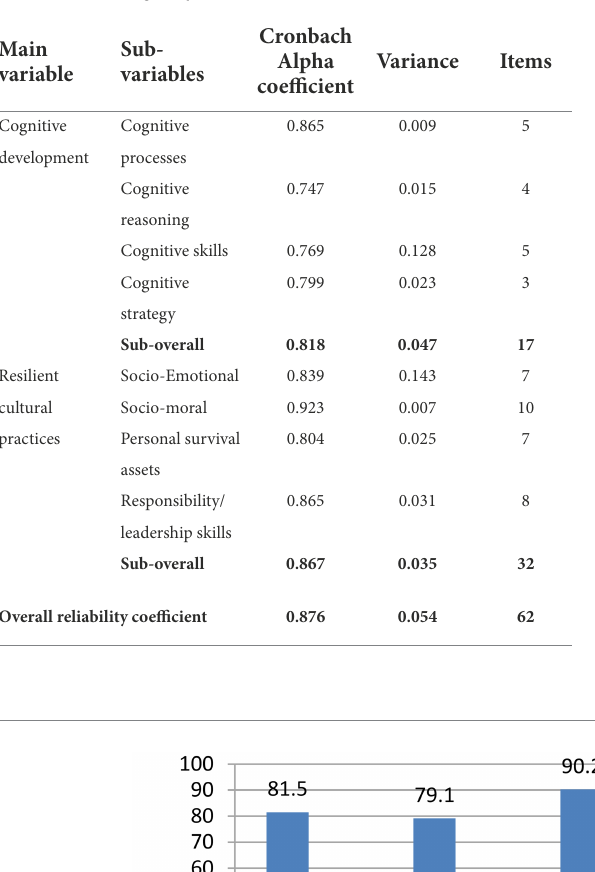
TABLE 2 Reliability of questionnaire.